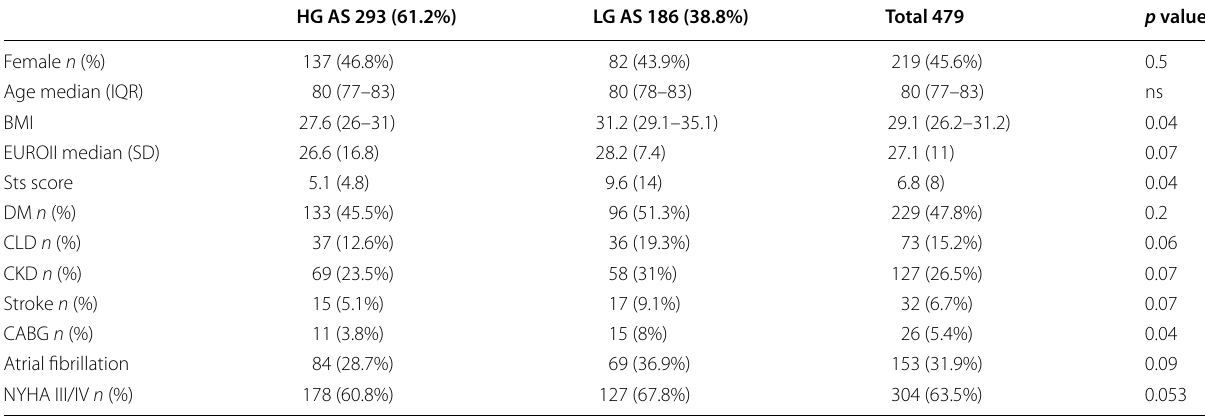
Table 1 Preoperative patients’